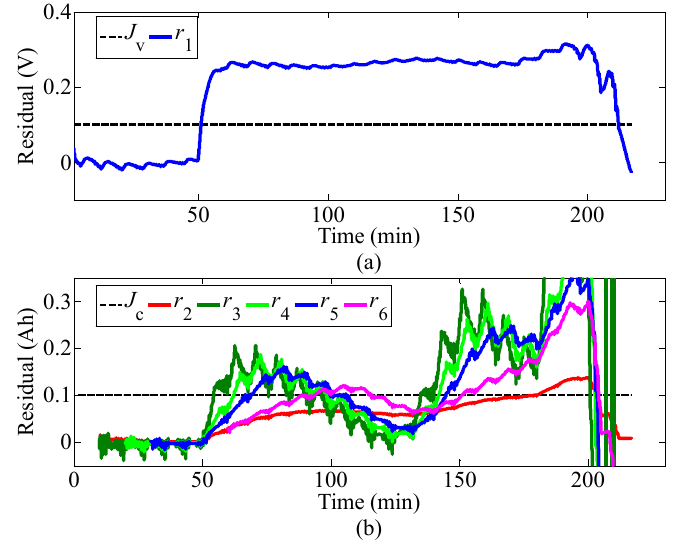
sensor fault, among the five capacity residuals, r 3 with a relatively smaller SOC change is still the first to exceed the threshold J c at 62.4 min. However, unlike the voltage sensor fault diagnosis, the capacity residuals take a shorter time to detect the current sensor fault than the OCV residual.